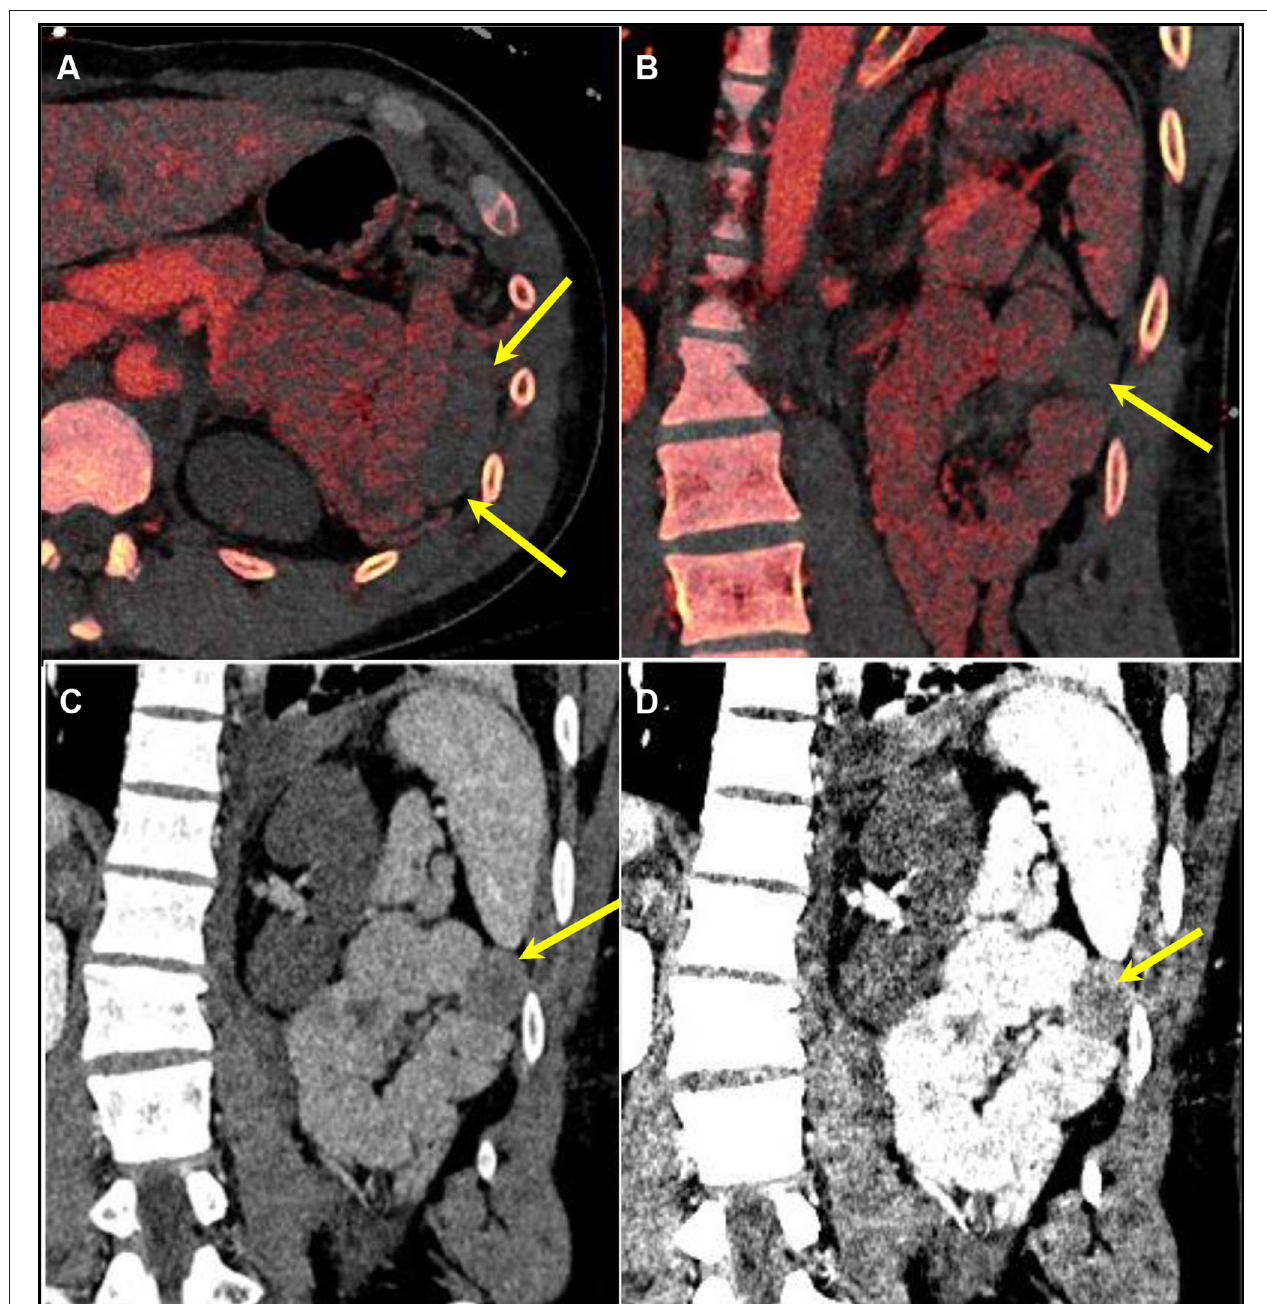
FIGURE 4 | A 25-year-old male patient presenting after a high-speed motor vehicle accident. [ (A) Axial and (B) ] Coronal DECT iodine overlay images demonstrating decreased iodine uptake in a left upper quadrant small bowel loop compared to the adjacent loop (yellow arrows). DECT VMI reconstructions at (C) 70 keV (equivalent to a conventional CT at 120 kVp) and (D) 40 keV demonstrating a higher difference in attenuation between the normal and abnormal loops at a lower energy level. DECT, dual-energy CT; VMI, virtual monoenergetic images.